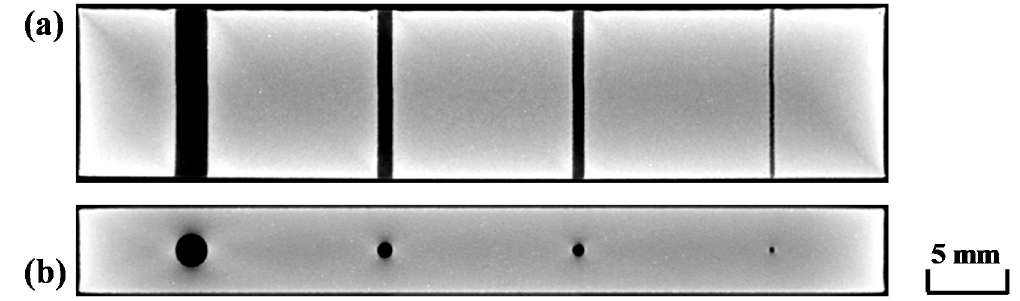
Figure 7. XCT test results: ( a ) sectional top view and ( b ) sectional front view.